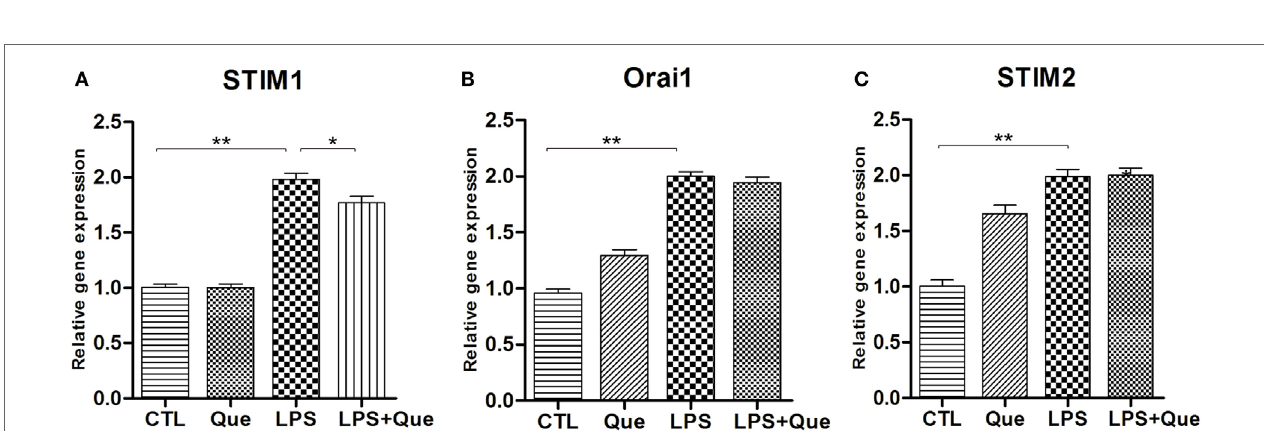
FigUre 4 | effect of Que on expression of sOce channel proteins in n9 cells exposed to lPs . Quantification of qRT-PCR showed (a) STIM1 mRNA, (B) Orai1 mRNA, and (c) STIM2 mRNA in N9 cells exposed to LPS with or without 24 h of Que (10 μ M) pretreatment. Values are normalized to GAPDH, a loading control. All data are means ± SEM. * p < 0.05, and ** p < 0.01 vs. indicated